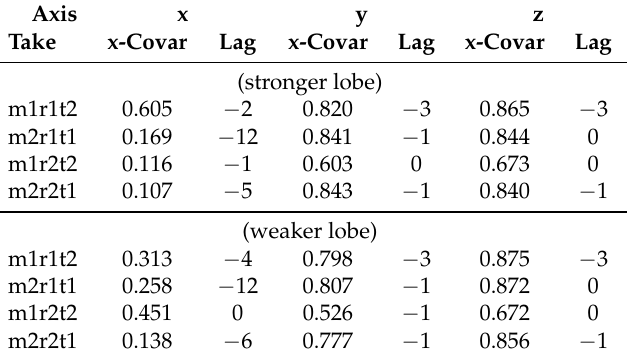
Table 5. Covariances (per axis) between mocap positional data and double integrated IMU data—selected takes from musicians 1 and 2. Axis x y z Take x-Covar Lag x-Covar Lag x-Covar Lag